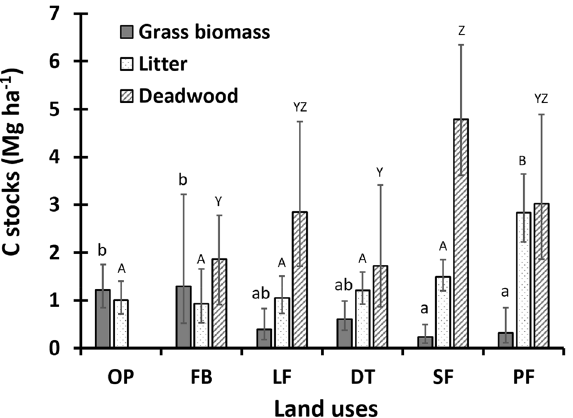
Figure 2. Average carbon stocks in grass biomass, ground litter, and deadwood material in different land- uses. OP = Open pastures, FB = Fodder banks, LF = Live fences, DT = Pasturelands with dispersed trees, SF = Secondary forests, PF = Primary forests. Error bars indicate the respective 95% confidence intervals. Different letters above the bars indicate significant differences between land-uses (p <